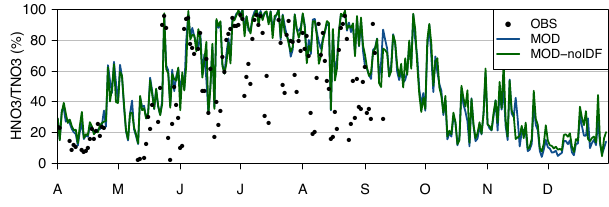
Figure 9. Daily HNO 3 / TNO 3